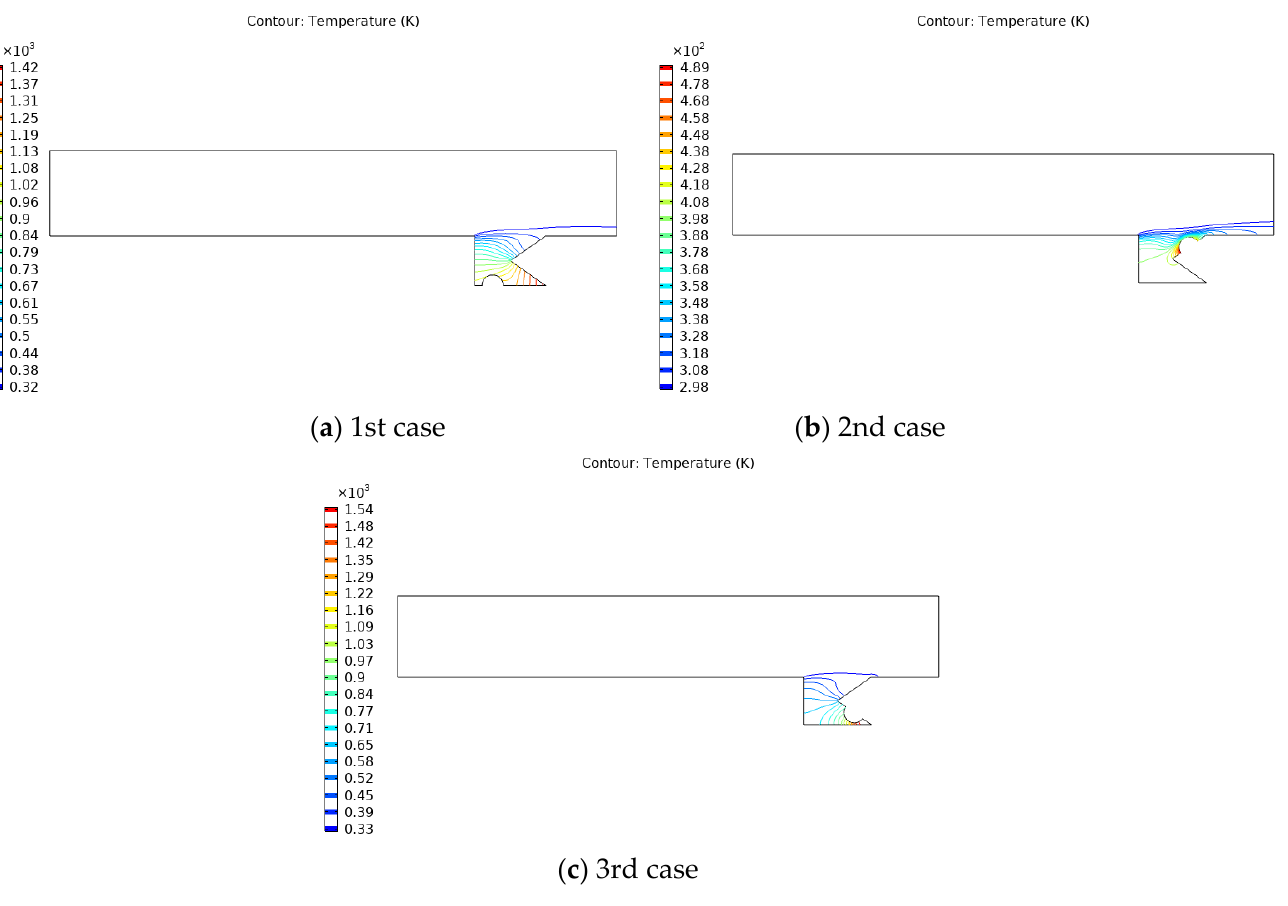
Figure 3 . Isotherm contour map . Figure 3. Isotherm contour